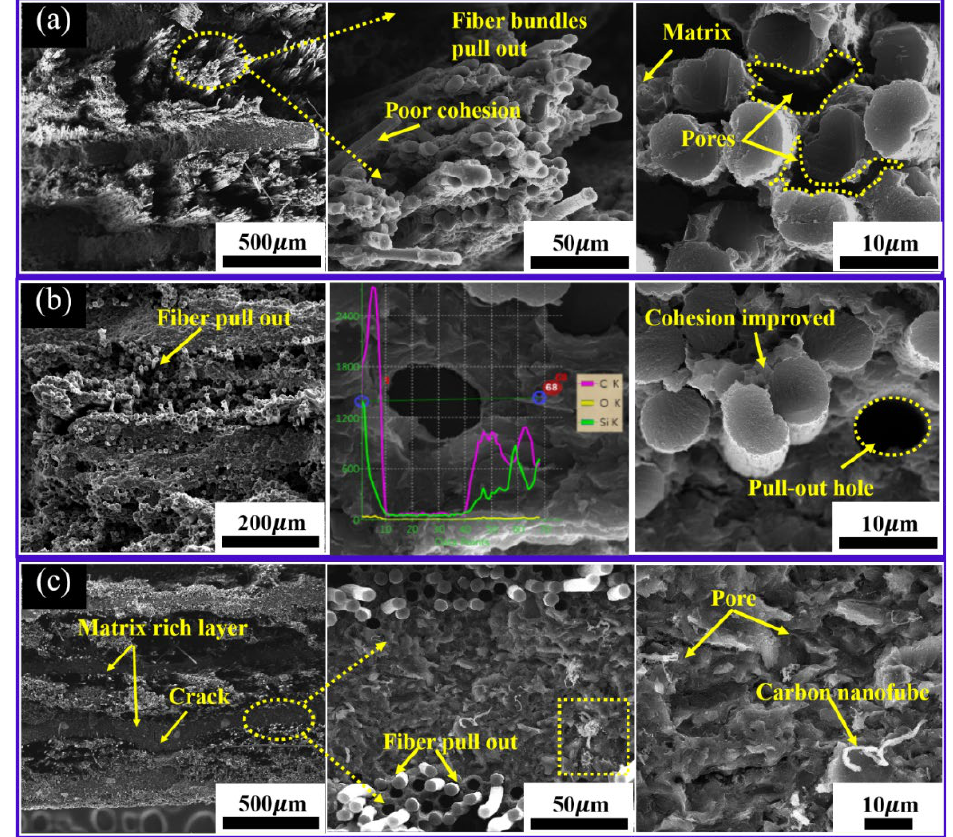
Figure 7. SEM images on the fracture surfaces: ( a ) Cf/C-SiC-50% composite; ( b ) Cf/C-SiC-60% composite; ( c ) Cf/C-SiC-70% composite.